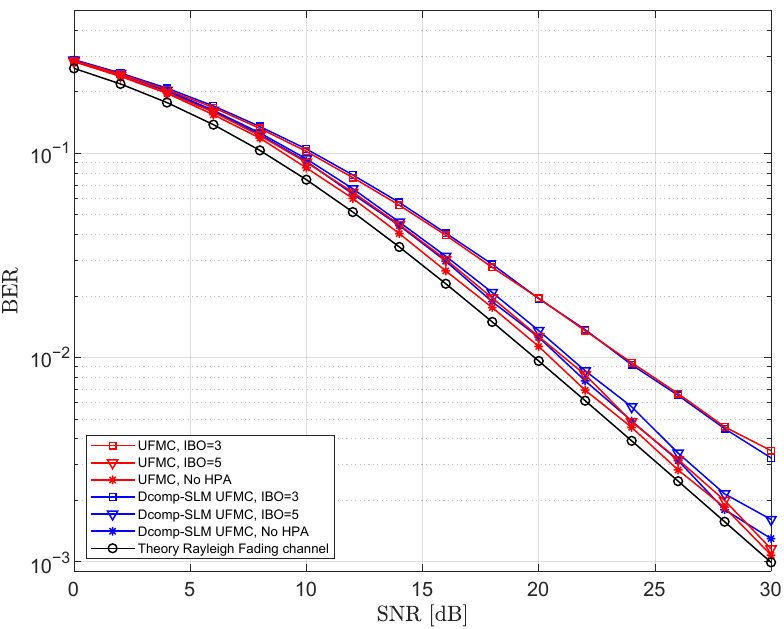
Figure 7. BER performances of the proposed Dcomp-SLM comparing to the original UFMC signal, in the presence of Rayleigh fading channel, for various IBO levels at N = 512 and U = 6